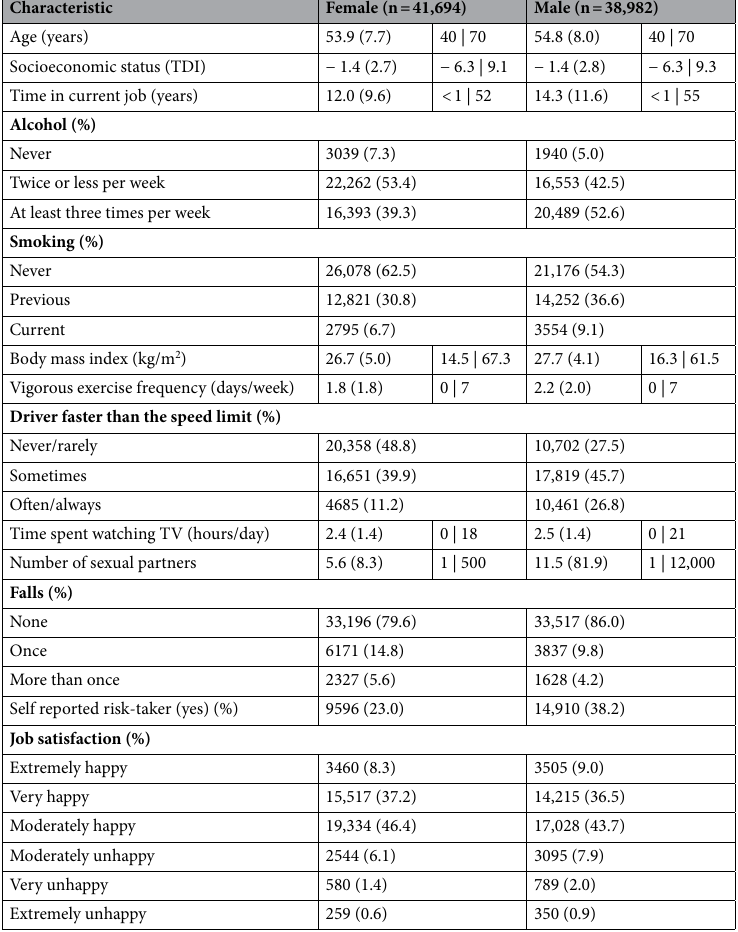
Table 1. Demographics of the study participants. Values are represented as (1) mean (standard) min | max, or (2) absolute number (percentage).